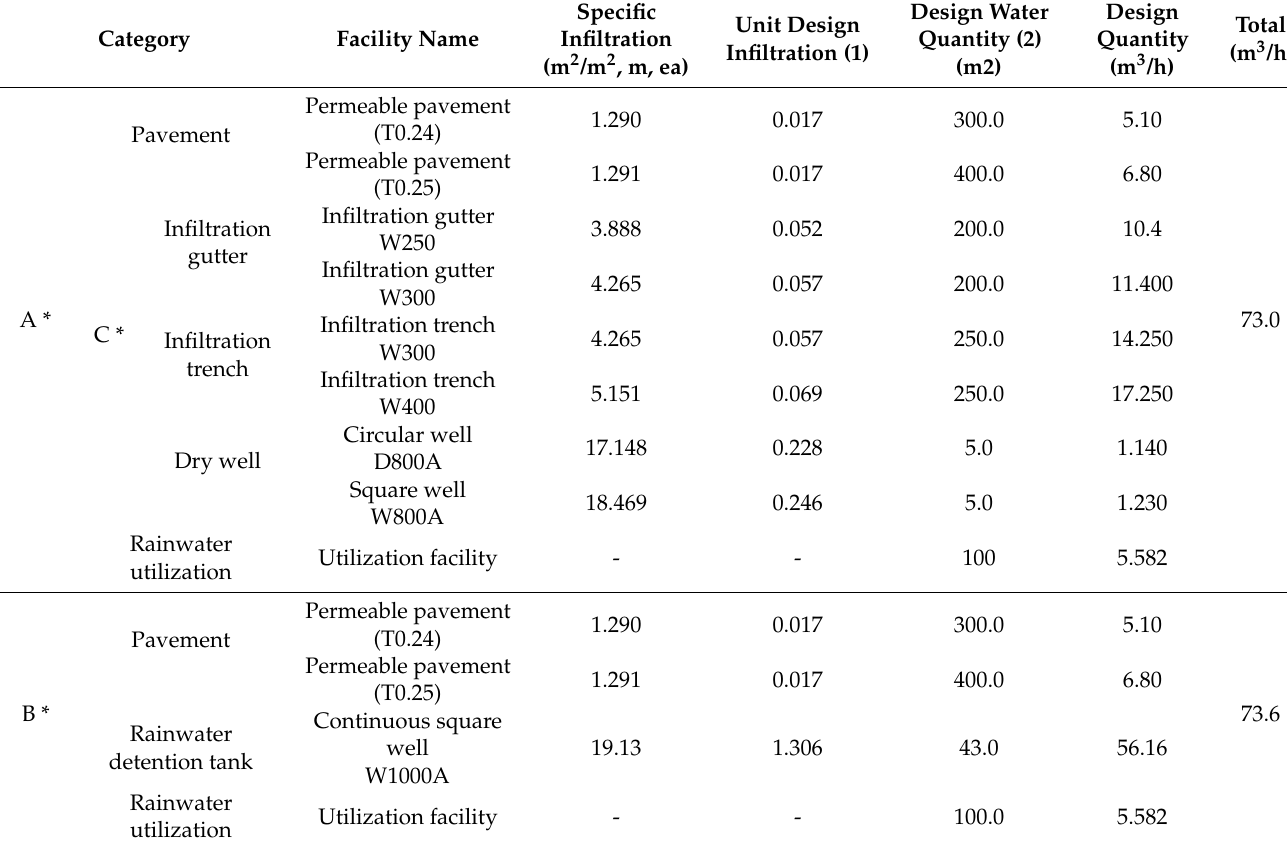
Table 12. Design water quantity of the existing system and eco-friendly rainwater detention system.